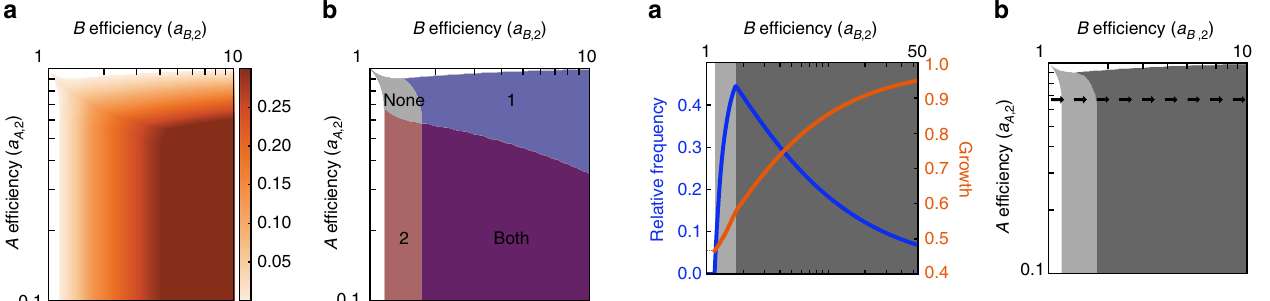
Fig. 3 The curse of increased ef fi ciency. a The relative frequency of type 2 cells (blue) and growth rate of the total population (orange) are shown as a function of the ef fi ciency of type 2 cells in producing metabolite B . We fi x a A = 0.67. As the ef fi ciency of type 2 cells increases, their relative ,2 frequency ultimately decreases. The population growth rate, however, increases with a higher metabolic ef fi ciency. b The shaded regions indicate where type 2 cell populations are increasing (light gray) or decreasing (dark gray) in relative frequency as they improve in ef fi ciency in producing metabolite B , that is, moving from left to right along the indicated line. In the dark-gray region, the relative frequency of cell type 2 decreases toward 0 as its ef fi ciency increases toward in fi